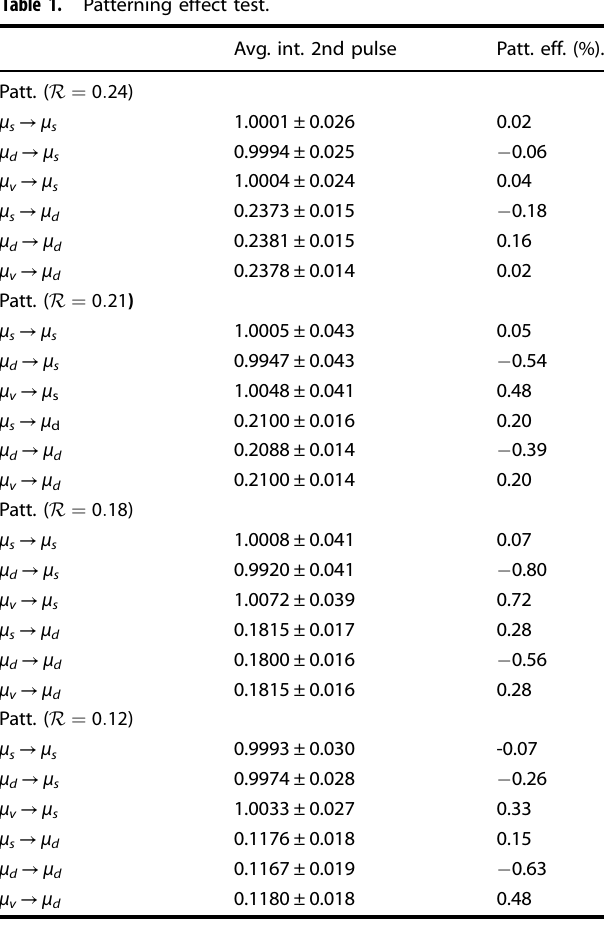
Table 1. Patterning effect test. Avg. int. 2nd pulse Patt. eff. (%).